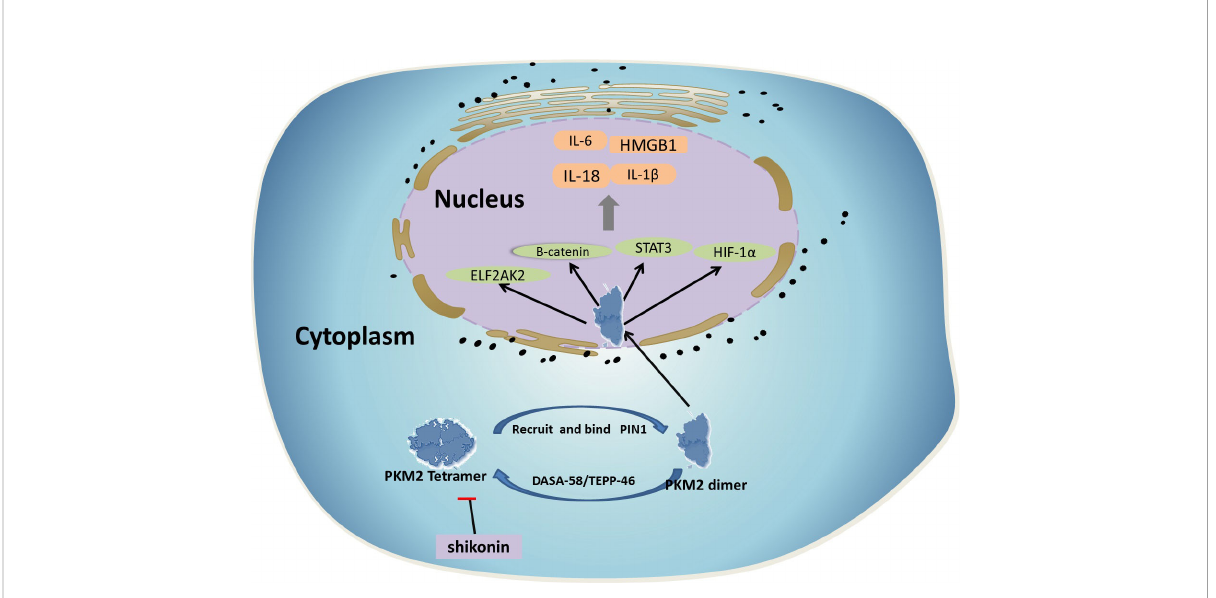
FIGURE 2 Among helper T cell subsets, PKM2 acts on the Stat family in proin fl ammatory T cell subset differentiation. 1) PKM2 regulates STAT1/STAT4 to induce Th1 cells formation and participates in cellular immunity. 2) PKM2 can then regulate STAT3 phosphorylation to regulate the differentiation of Th17 cells, participating in in fl ammation related diseases. 3) PKM2 can regulate STAT5 with TGF- b Binding, induces Tregs formation and maintains immune